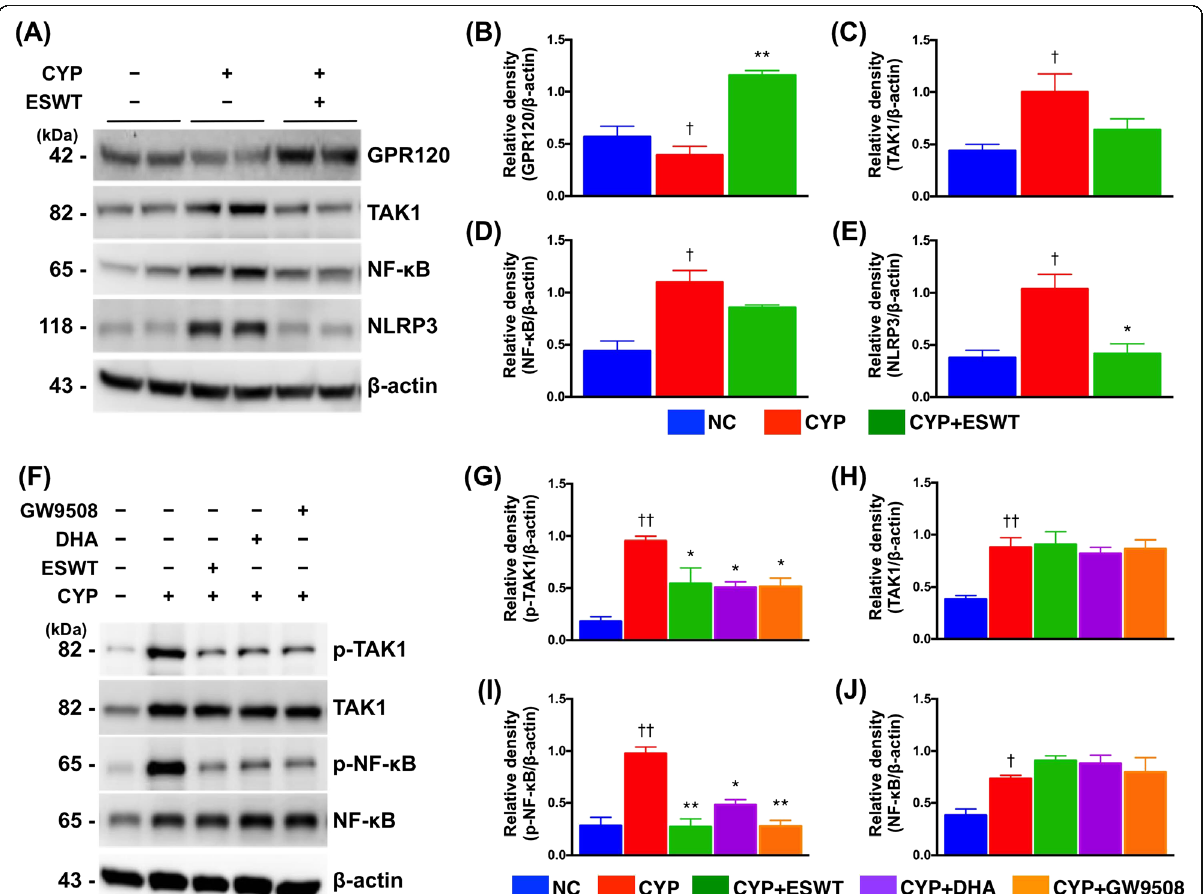
Fig. 2 Effects of extracorporeal shock wave treatment (ESWT) and GPR120 agonists on cyclophosphamide (CYP)-stimulated inflammatory response in urothelial RT4 cells. a-e Protein expressions of pro-inflammatory (i.e., TAK1, NF- κ B and NLRP3) and anti-inflammatory (i.e., GPR120) markers in CYP-treated RT4 cells at 24 h with and without prior ESWT. f-j Protein expressions of active pro-inflammatory markers (i.e., p-TAK1 and p-NF- κ B) in CYP-stimulated RT4 cells at 4 h with and without prior treatment with GPR120 agonists (i.e., GW9508 and DHA) compared to those elicited through ESWT. β -actin used as internal control for immunoblotting. Values expressed as the mean ± SD of three independent experiments. * p < 0.05, ** p < 0.01 vs. CYP; † p < 0.05, †† p < 0.01 vs. control; Significance of differences determined by one-way ANOVA followed